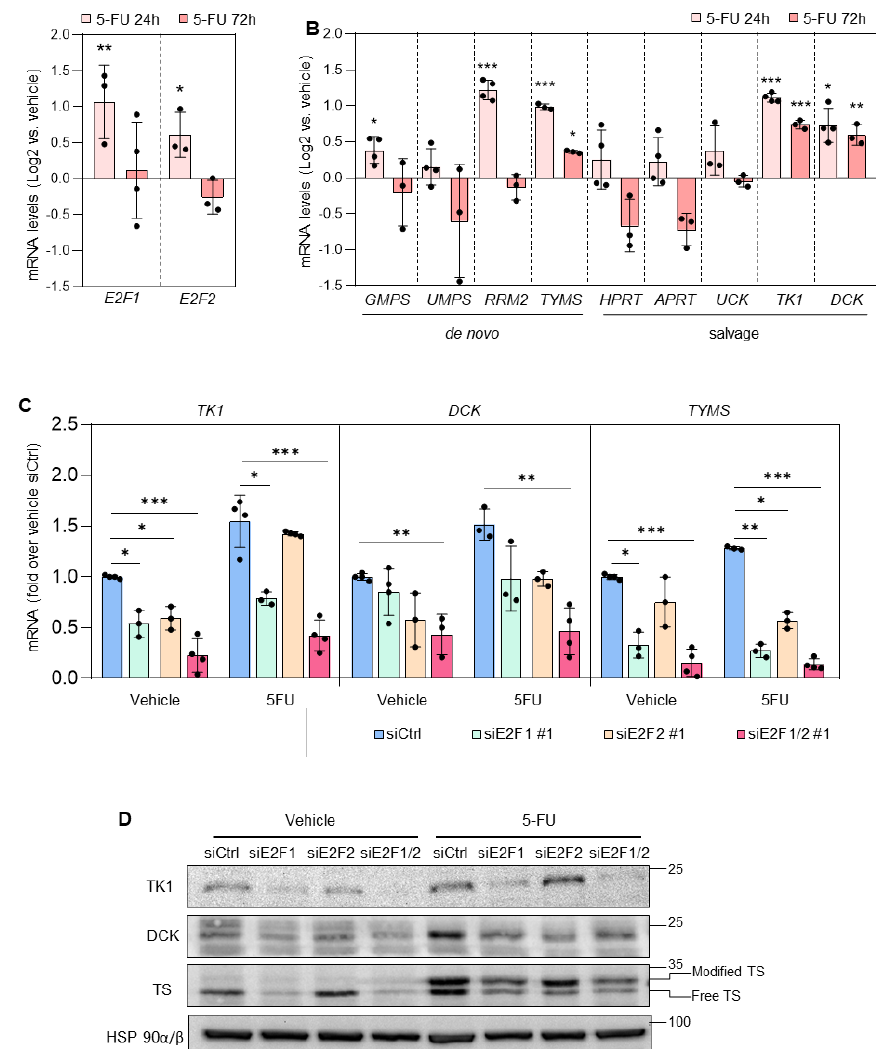
Figure 3. E2F1 and E2F2 are necessary for 5-FU-mediated sustained upregulation of TYMS , TK1 and DCK . ( A , B ) RT-QPCR was carried out to analyze the expression of E2F1 and E2F2 ( A ) and their target genes involved in nucleotide biosynthesis ( B ) in PC3 cells after 24 and 72 h of 5-FU (5 µ M) treatment compared with sample treated with vehicle. ( C ) RT-QPCR analysis of TK1 , DCK and TYMS in PC3 cells 96 h after transfection with non-target control siRNAs (siCtrl), siRNAs specific for E2F1 (siE2F1#1), E2F2 (siE2F2#1) or with their combination (siE2F1/2#1) and treated for the last 72 h with vehicle or 5-FU (5 µ M). In ( A – C ), L19 mRNA was used as the normalization control. The values are expressed as Log2 ratio vs. vehicle control ( A , B ) or fold over siCtrl ( C ) and are the results (mean ± SD) of three independent experiments. Statistical analysis was performed using ANOVA and Fisher’s test. *** p < 0.0001; ** p < 0.001, * p < 0.05. ( D ) Representative Western blot analysis of TK1, DCK and TS in extracts prepared from PC3 cells 96 h after transfection with siCtrl, siE2F1#1, siE2F2#1, or siE2F1/2#1 and treated for the last 72 h with 5-FU (5 µ M). HSP90 was used as loading control. Note the presence of 5-FU-modified TS (inactive) in treated